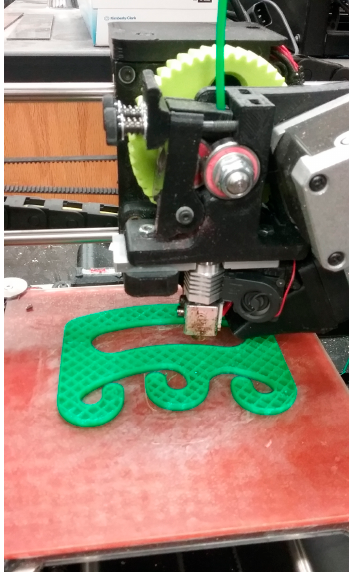
Figure 1. Lulzbot Mini mid-print using poly lactic acid and Cura Quick Print settings.